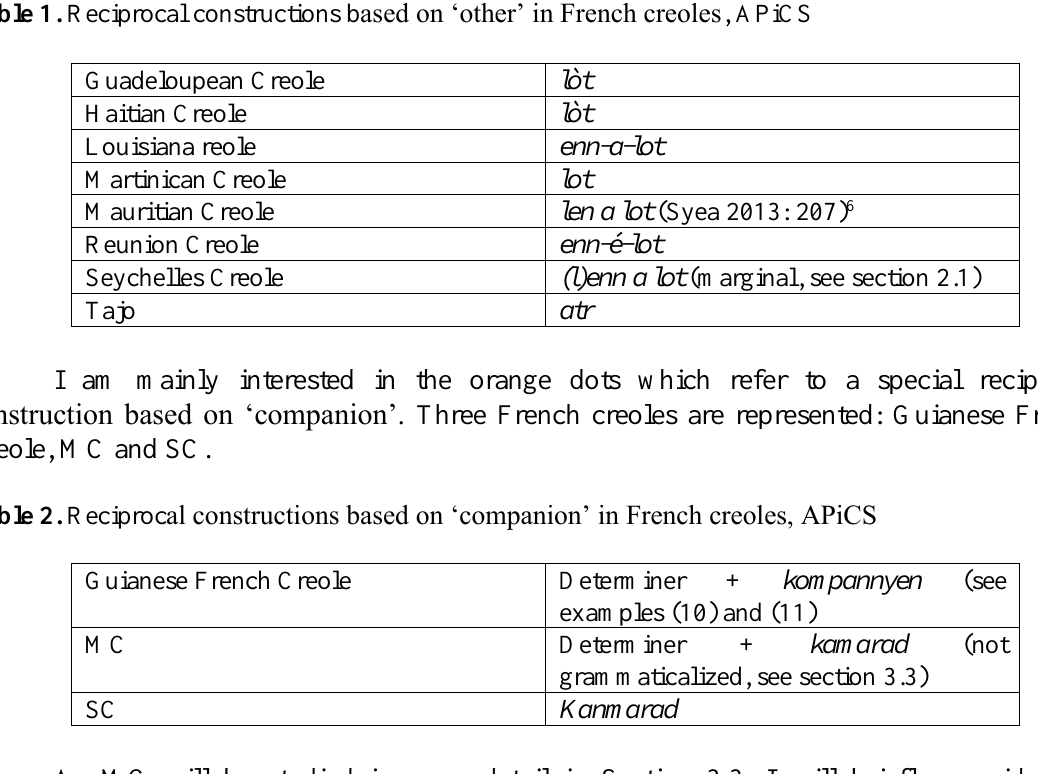
Table 1. Reciprocal constructions based on ‘other’ in French creoles, APiCS